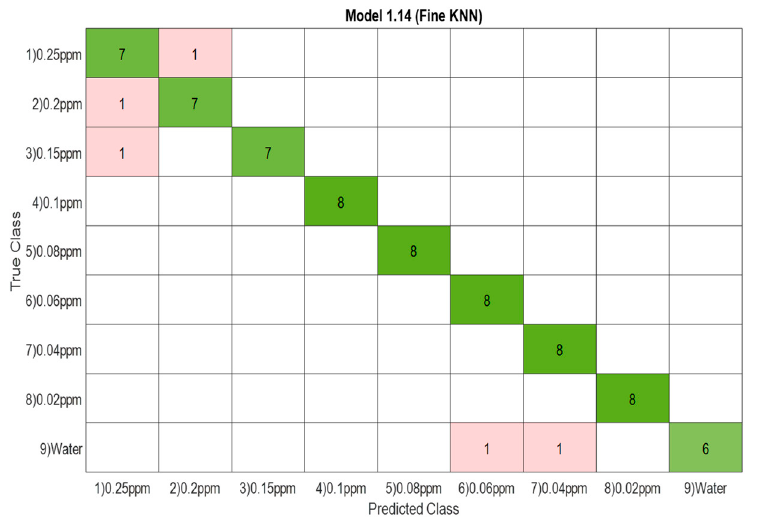
Figure 13. Confusion matrix for the preset-fine kNN model for classifying Nativo pesticide at different concentrations against distilled water samples.